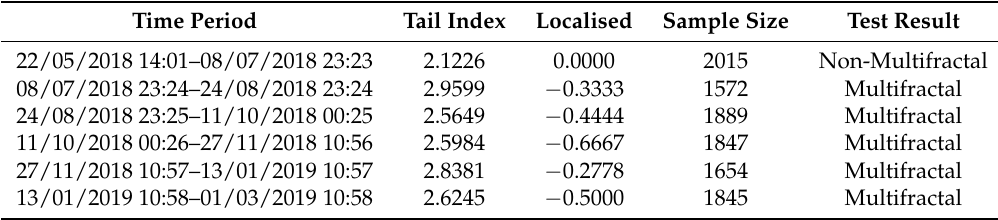
Table A4. Local hypothesis test results on high frequency Bitcoin open prices.